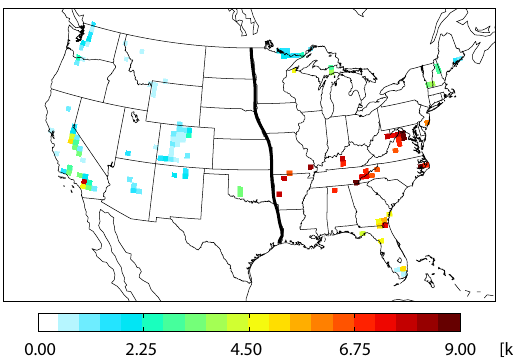
Figure 9. CL exceedance in Class I areas; color indicates magni- tude of exceedance. The size of Class I areas is not reflected. Grid cells containing Class I areas are shown as colored regardless of the fraction of Class I areas. Bold line divides Western and Eastern US.